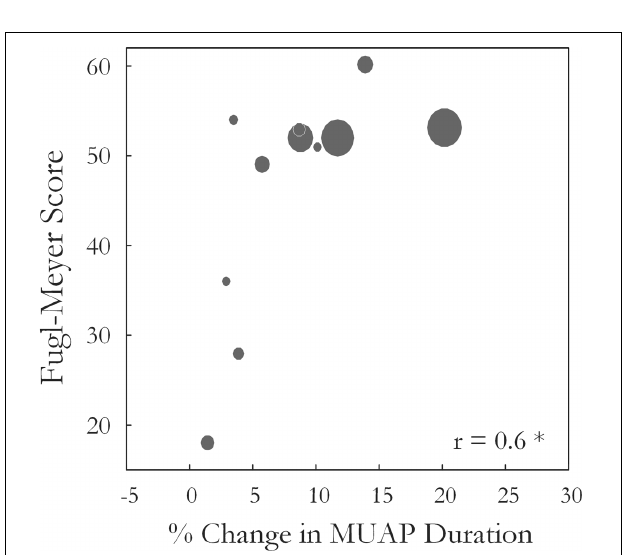
FIGURE 6 | The Wrist and Hand Upper Extremity Fugl-Meyer score for each subject is plotted against the percentage change in median MUAP duration from pre- to post-fatigue observed for that subject ( r = 0.6, p = 0.04). Larger circles indicate longer times to task failure for the sustained fatiguing